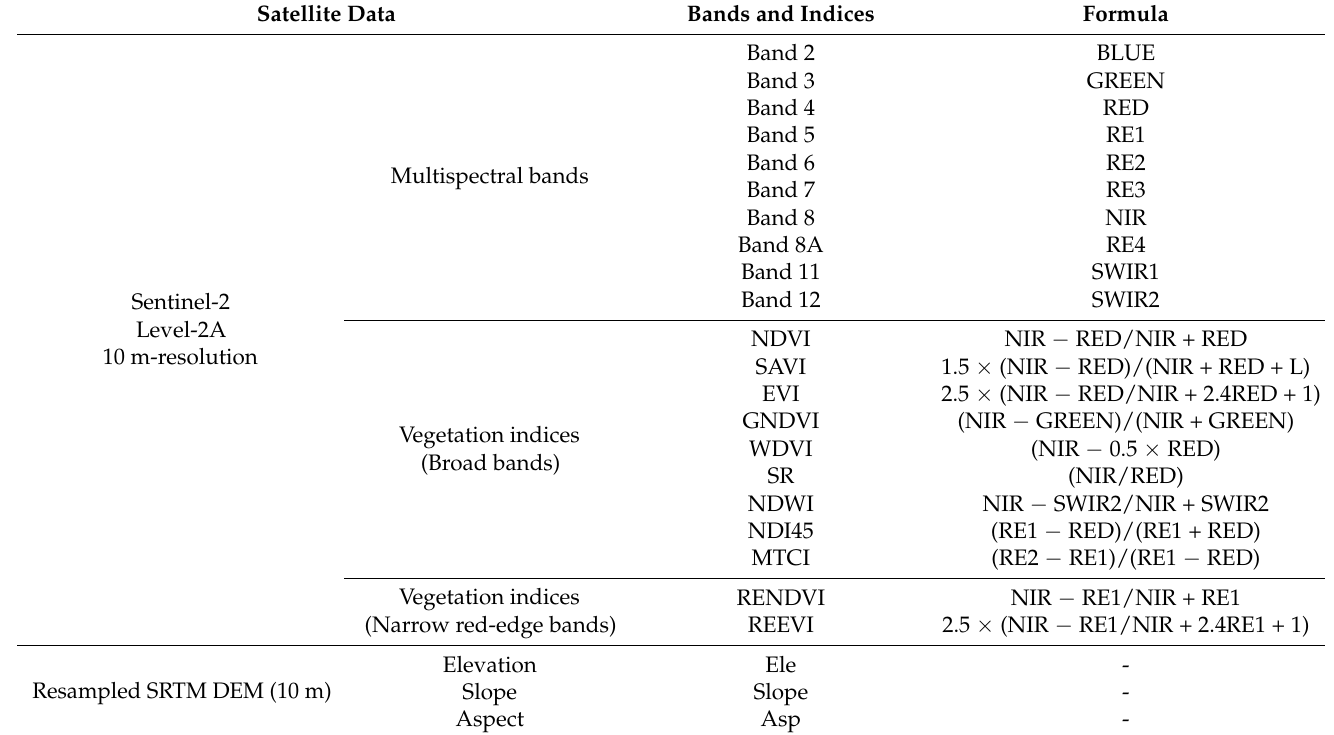
Table 2. List of Sentinel-2-derived variables and topographic factors used in AGB